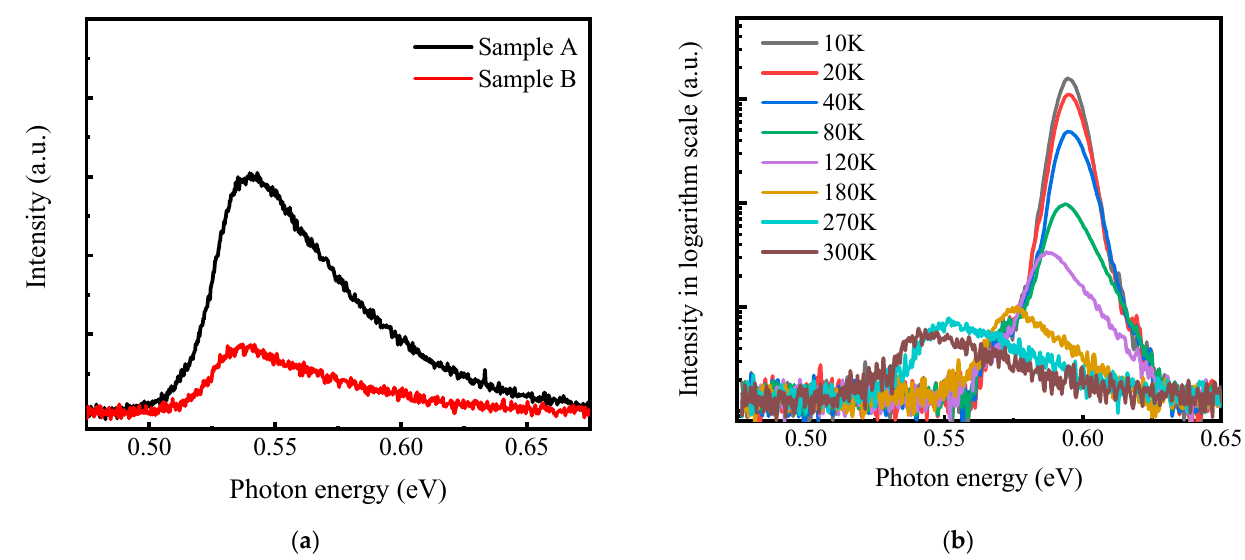
Figure 6. ( a ) PL spectra of extended wavelength InGaAs sample at room temperature. ( b ) PL spectra of extended wavelength InGaAs sample A at different temperatures from 10 K to 300 K (Intensity is plotted in logarithm scale).